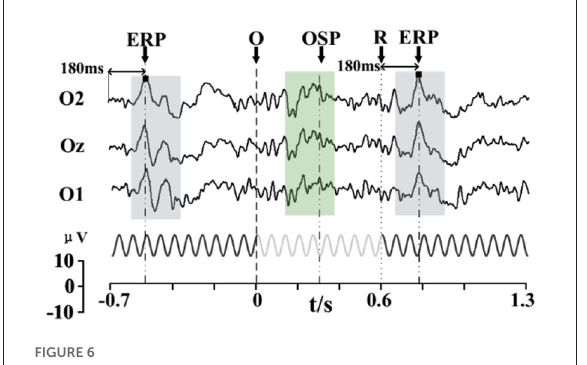
FIGURE6 Stimulus sequence of the stimulator with 0.6s duration, and the averaged typical EEG responses (64 trials). The green shaded area represents the OSP features, while gray shaded areas represent the main ERP features.